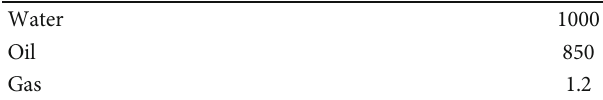
Table 4: Fluid densities (kg/m 3